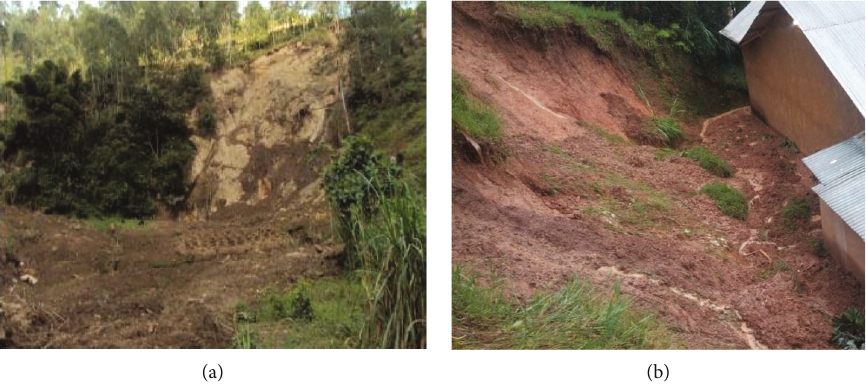
Figure 2: Pictures of landslides in the study area during 2016 (a) and 2020 (b)